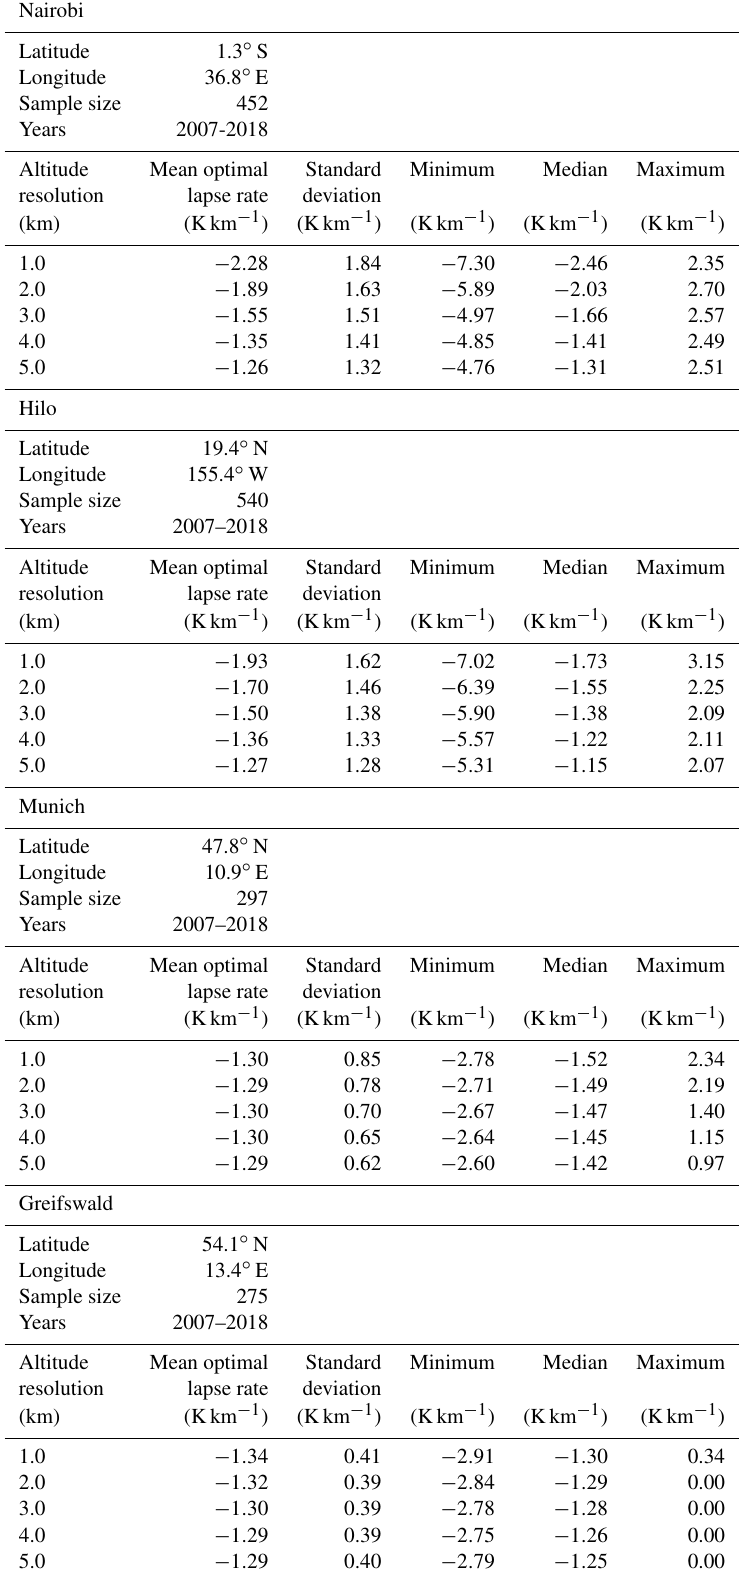
Table 5. Statistics for lapse rate